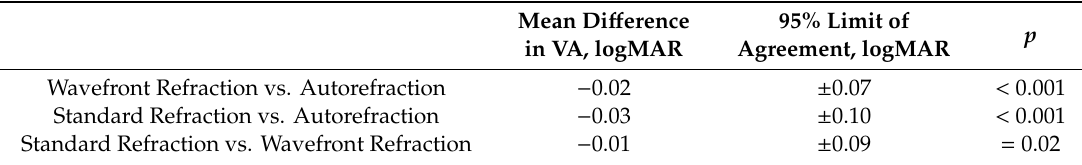
Table 2. Mean differences in visual acuity reached with each method and 95% limits of agreements. Mean Difference in VA, Wavefront Refraction vs.